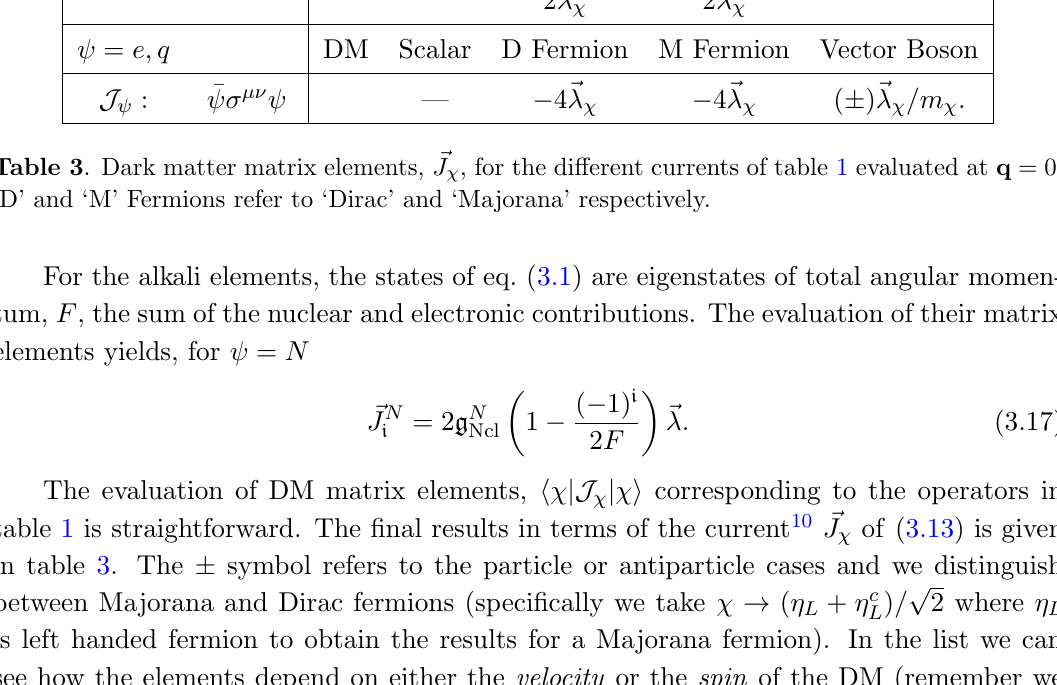
= e; q DM Scalar D Fermion M Fermion Vector Boson